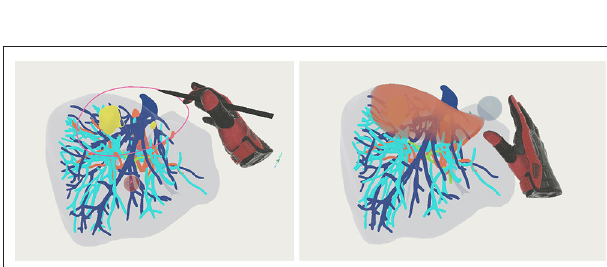
FIGURE 3 | Visualization of the line drawing, clips and volume marking functionality—left: one clip and a line are added to the model; right: using the ball shaped tool at the hand the red volume was